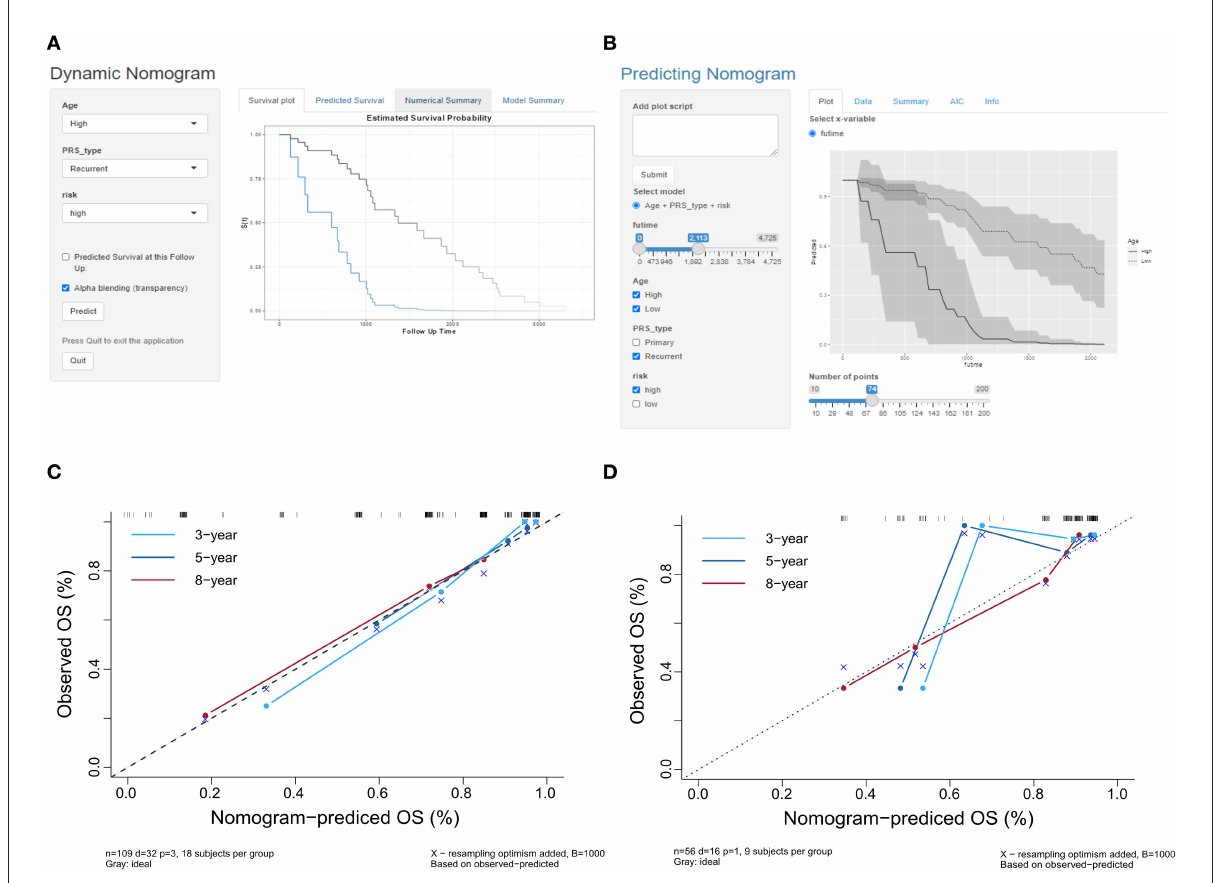
FIGURE4 (A,B) Scripts were generated to predict the probability of survival for a patient at a specific time point. (C) The calibration curves in the training cohort show that the predicted values at 3, 5, and 8 years are close to the observed values. (D) The calibration curves at 3, 5, and 8 years showed that the prediction accuracy of the prognosis model was acceptable, and the model had the highest accuracy in predicting 8 year survival.